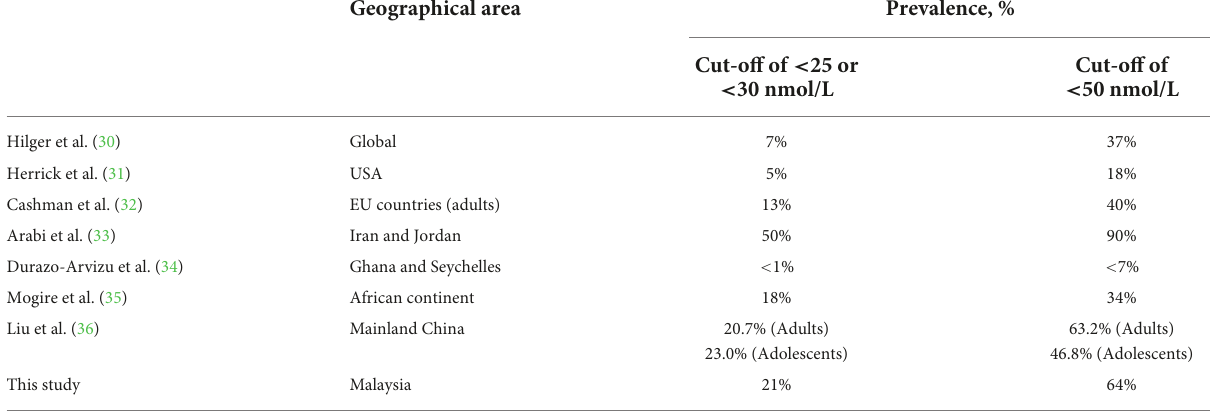
TABLE 2 Vitamin D deficiency by geographical area and 25-hydroxyvitamin D cut-offs, updated from Bouillon (24). Geographical area Prevalence, % Cut-off of < 25 or Cut-off of < 30 nmol/L < 50